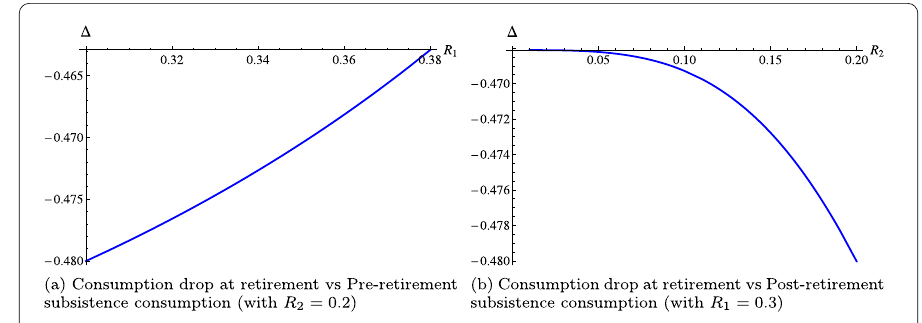
Figure 3 Consumption drop at retirement and subsistence consumption (parameters: ρ = 0.03, r = 0.03, μ = 0.07, σ = 0.2, α = 0.5, I 1 = 1, I 2 = 0.5, ¯ γ 1 = 2, ¯ γ 2 = 5, L =